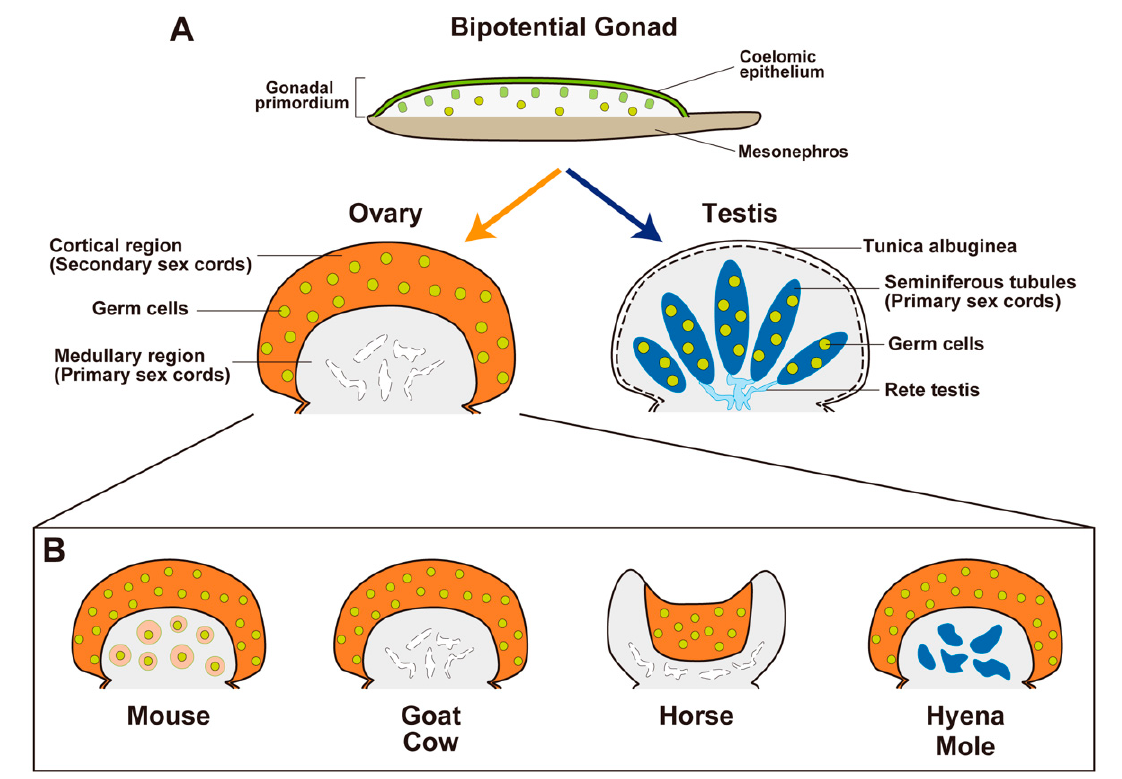
Figure 3. Sexual differentiation of bipotential gonads and the histological variations of ovaries in the indicated species. ( A ) Bipotential gonads differentiate into testes or ovaries. In mammalian testes, primary sex cords form tubular structures (seminiferous tubules (deep blue) with germ cells (yellow dots)) and the rete testis (cyan), which provide a route for continuous sperm transportation from the seminiferous tubules to the efferent ducts. Interstitial components are shown in gray. Mammalian ovaries commonly develop secondary sex cords with germ cells in the cortical region as a site of future folliculogenesis (orange; yellow dots, germ cells). However, the morphological characteristics of primary sex cords in the medullary region of the ovary show considerable diversity among mammals. ( B ) In the ovaries of goats and cows, secondary sex cords in the cortical region form during the fetal period. Germ cells in the medullary region disappear and the primary sex region regresses. In the ovaries of mice, secondary sex cords in the cortical region are not distinct in the fetal period; germ cells in the medullary region are maintained and develop immediately after birth as the first wave of follicles (pale-orange circles with yellow dots). In the ovaries of spotted hyenas and most mole species, the medullary region develops as a male-like tissue with Leydig-cell-like steroidogenic cells (deep blue). In the ovaries of horses, the cortical region (in which folliculogenesis occurs) is surrounded by the well-developed medulla and forms a unique structure known as the ovulation